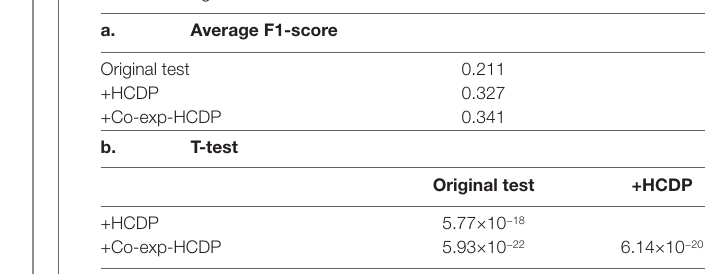
TABLE 2 | The inclusion of HCDPs filtered by gene co-expression (GCE-HCDP) to generate extended gene sets led to an overall improved target prioritisation performance when compared with the inclusion of unfiltered HCDPs and un-extended gene